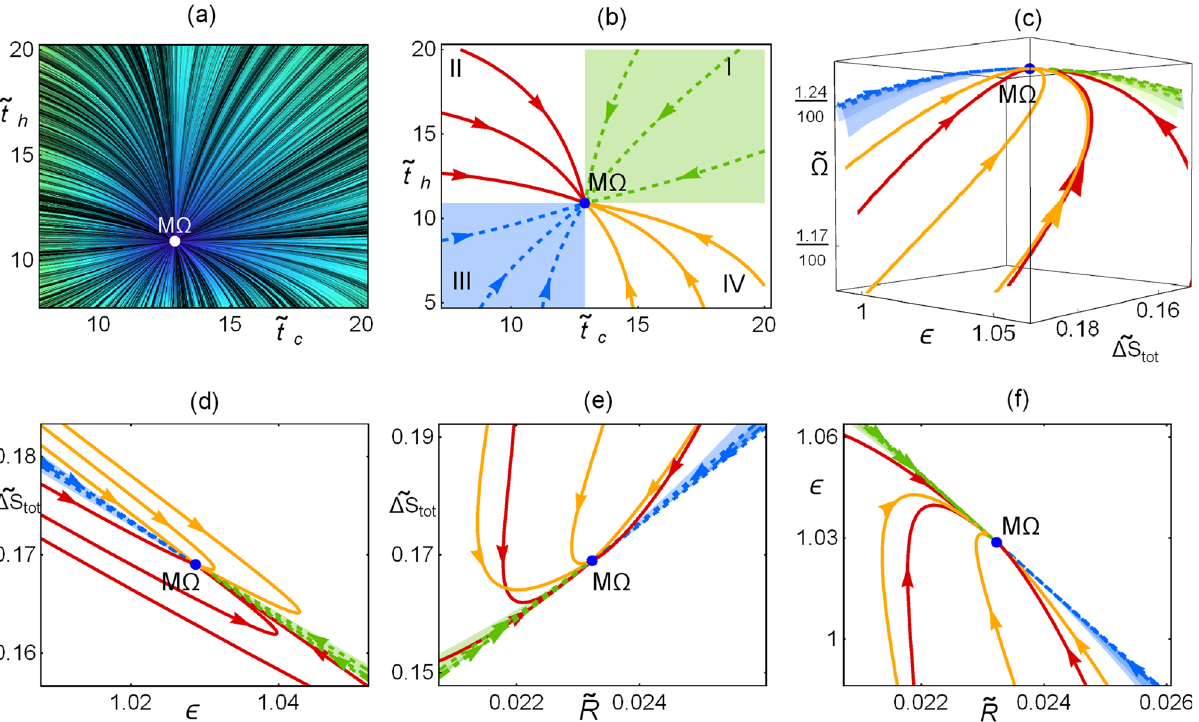
Figure 9. ( a ) Line integral convolution plot of the dynamic equations (22), simulating streamlines over random conditions. ( b ) Trajectories towards relaxation in the phase space. ( c ) Trajectories in the ε –* σ surface. ( d – f